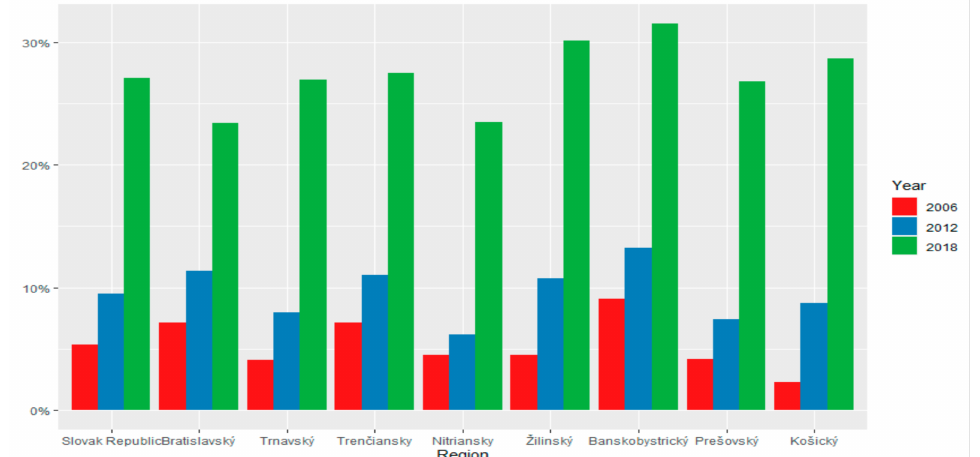
Figure 5. Development of waste sorting productivity according to the